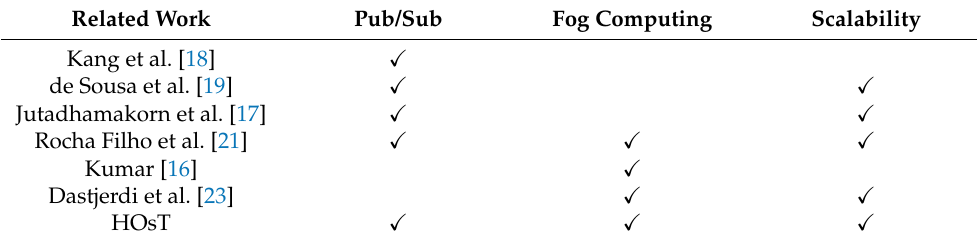
Table 1. Comparison of this work with the related